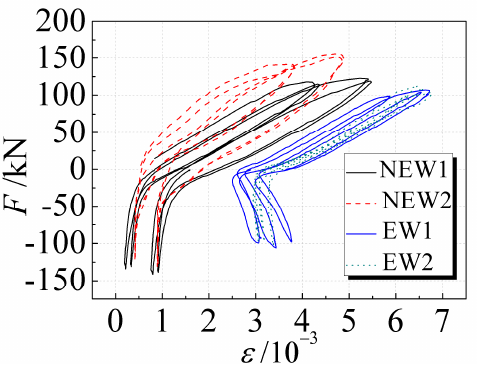
Figure 12. Reinforcement load-strain hysteresis curves at the bottom of the lattice side column.